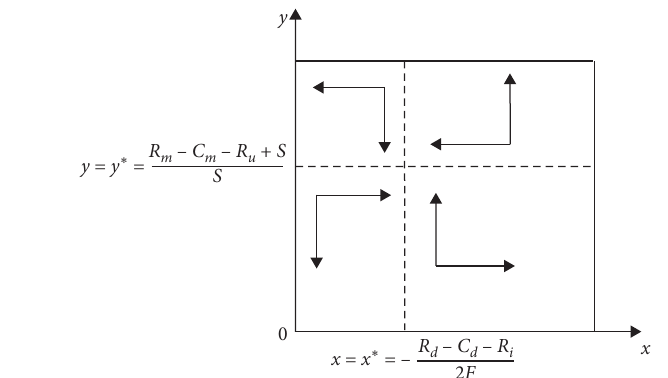
Figure 3: The evolution game of enterprise owners and professional managers.